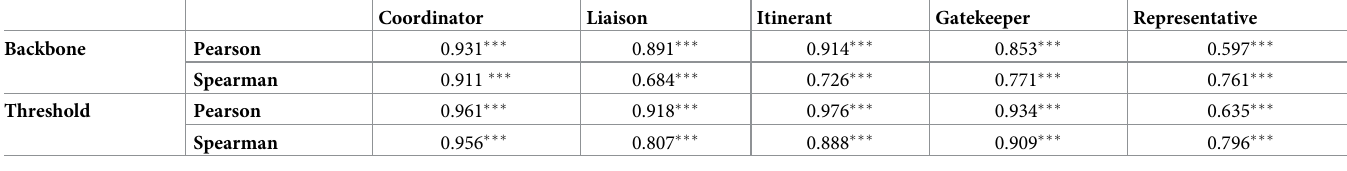
Table 4. Correlation analysis of WNGF results with the backbone and threshold network on the organizational